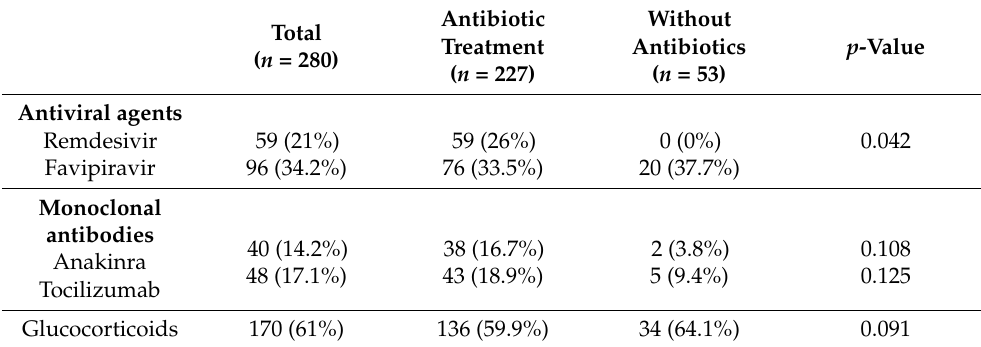
Table 3. Associated therapeutic regimens.